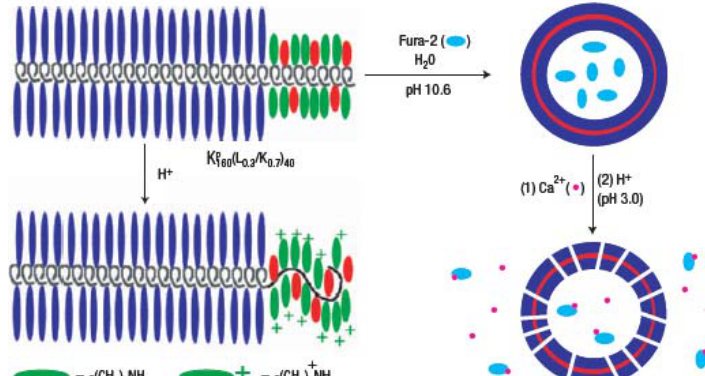
Figure 6. pH responsive polypeptide vesicles. Schematic illustration of a